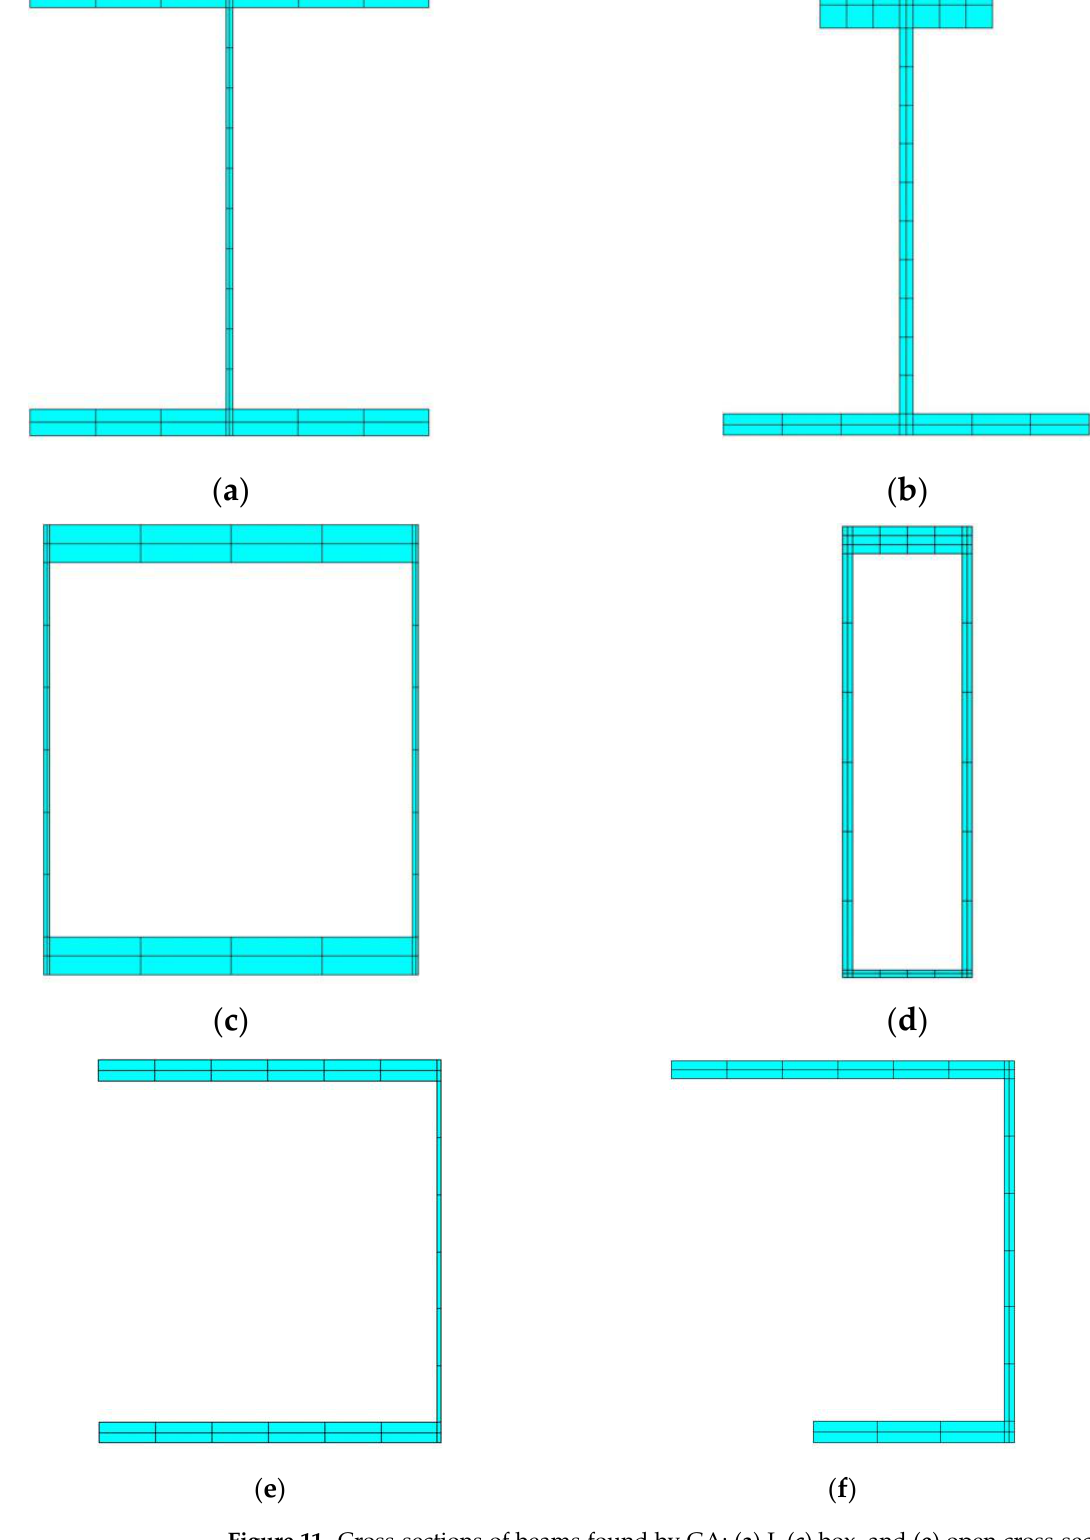
Figure 11. Cross-sections of beams found by GA: ( a ) I, ( c ) box, and ( e ) open cross-sections for FT beams; ( b ) I, ( d ) box, and ( f ) open cross-sections for FTCT beams.